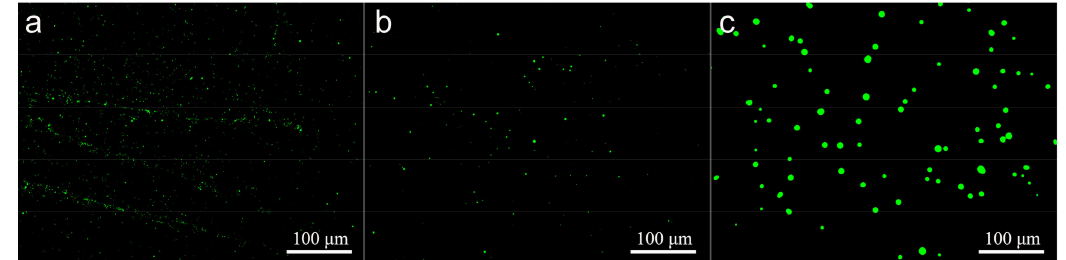
Figure 12. Fluorescence microscopy images of coumarin 6-loaded azoxystrobin microspheres. ( a ) MS1;